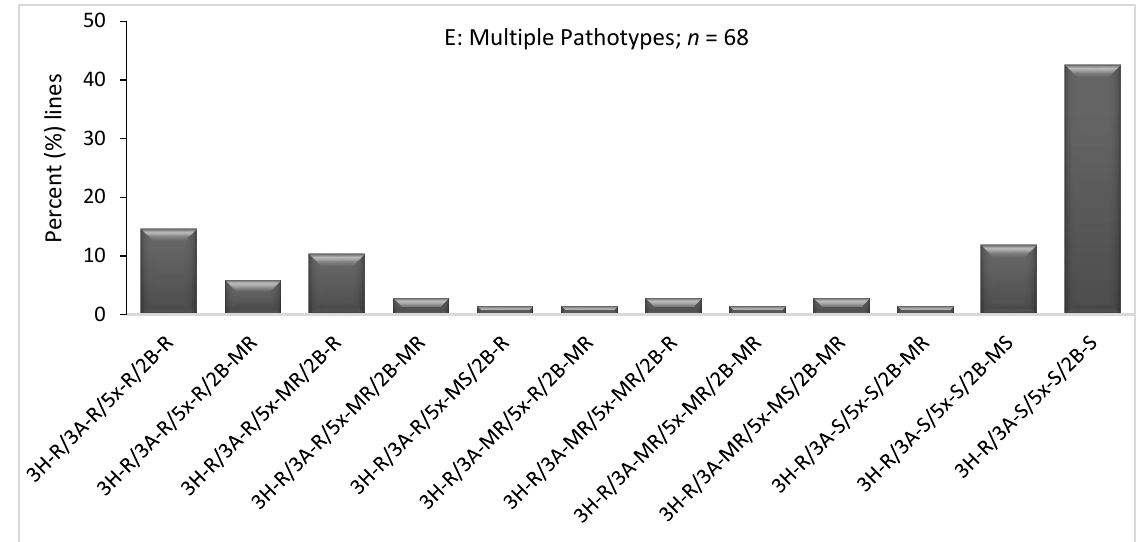
Figure 1. Distribution of the BC 1 F 8 generation Brassica napus lines derived from the ( B. napus × B. rapa ) × B. napus interspecific cross exhibiting clubroot resistance under field conditions and to dif- ferent Plasmodiophora brassicae pathotypes under greenhouse conditions: ( A ) Field condition in Al- berta, ( B ) pathotype 2B, ( C ) pathotype 5x (L-G1), ( D ) pathotype 3A, ( E ) multiple pathotypes ( x -axis: 3H-R/3A-R/5x-R/2B-R = resistant to all pathotypes (3H, 3A, 5x and 2B); 3H-R/3A-R/5x-R/2B-MR = resistant to pathotypes 3H, 3A and 5x while moderately resistant to pathotype 2B; 3H-R/3A-R/5x- MR/2B-R = resistant to pathotypes 3H, 3A and 2B while moderately resistant to pathotype 5x; 3H- R/3A-R/5x-MR/2B-MR = resistant to pathotypes 3H and 3A while moderately resistant to pathotypes 5x and 2B; 3H-R/3A-R/5x-MS/2B-R = resistant to pathotypes 3H, 3A and 2B while moderately sus-